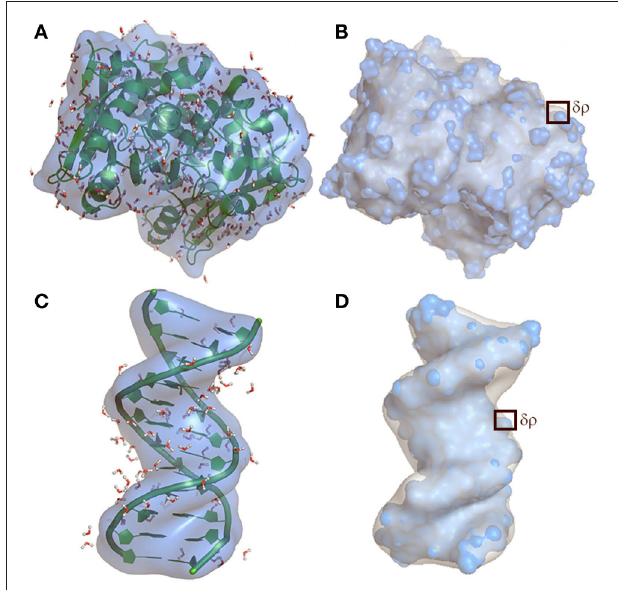
FIGURE 4 | Top (A,B) : Gaussian map of the protein and Bottom (C,D) : of the DNA dodecamer. (A,C) highlights smoothed Gaussian mapping of the macromolecules, at 5 Å resolution, indicating crystallographic distribution of the water molecules on the surface. (B,D) shows the mapping of the macromolecules at two different resolutions, capturing surface thickness variation incorporated in δρ . Blue surface is mapping at 2 Å resolution and indicates distribution of the atoms on the surface, while light gray is the smoothed Gaussian map indicating how surface thickness may vary if free diffusion of the solvent molecules on the surface is taken into